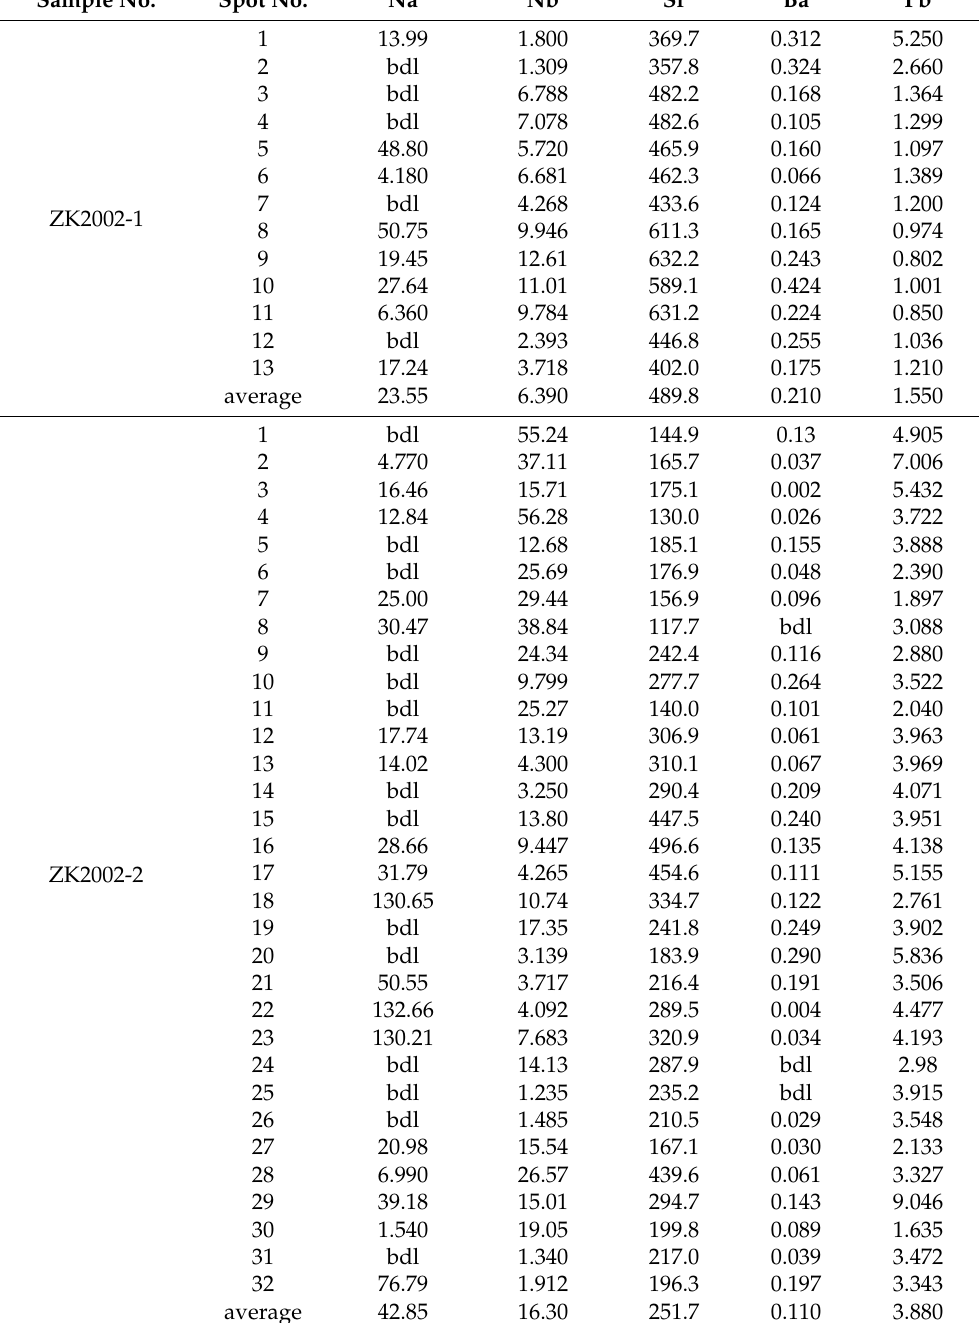
Table 2. Results of trace element analysis in scheelite from Tongshankou deposit (ppm). Sample